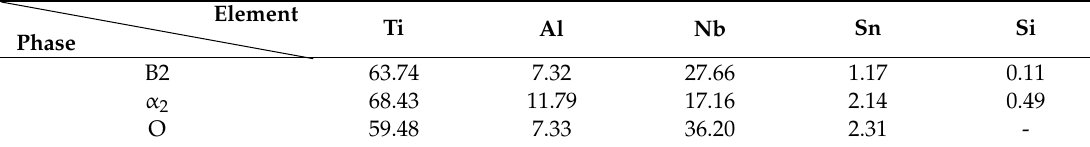
Table 2. Elementary composition of B2, α 2 , and O phases.